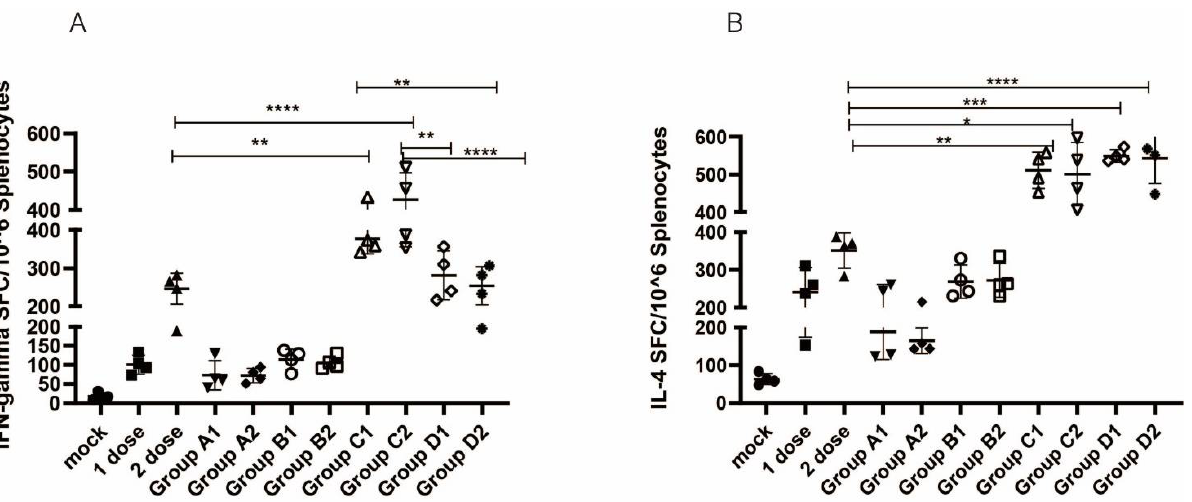
Figure 4. SARS-CoV-2 RBD-specific T-cell responses analyzed by ELISPOT: ( A ) RBD-specific IFN-γ and ( B ) RBD-specific IL-4 responses were measured. 1 dose: 1 dose inactivated vaccine control group; 2 dose: 2 doses inactivated vaccine control group; one-way ANOVA (and nonparametric or mixed) was conducted; * p < 0.05; ** p < 0.01; *** p < 0.001; **** p < 0.0001 versus the control